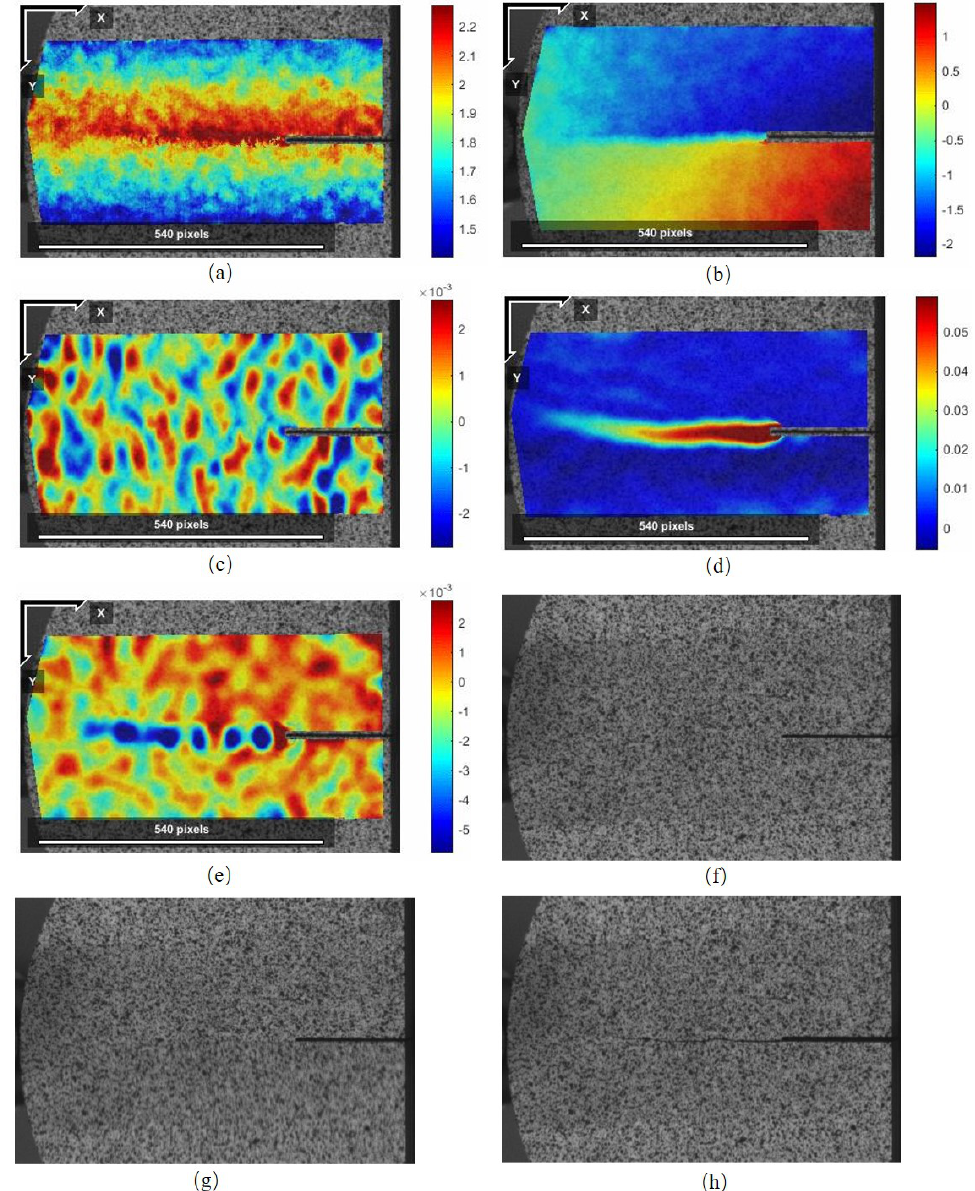
Figure 14. Displacement field, strain field, and photos of specimen S2 before and after fracture: ( a ) distribution field of vertical displacement U before the occurrence of the S2 fracture; ( b ) distribution field of horizontal displacement V before the occurrence of the S2 fracture; ( c ) distribution field of strain ε x before the occurrence of the S2 fracture; ( d ) distribution field of strain ε y before the occurrence of the S2 fracture; ( e ) distribution field of strain ε xy before the occurrence of the S2 fracture; ( f ) photo before the occurrence of the S2 fracture (the original 2932th photo); ( g ) photo during the occurrence of the S2 fracture (the original 2933th photo); ( h ) photo after the S2 fracture (the original 2934th photo).